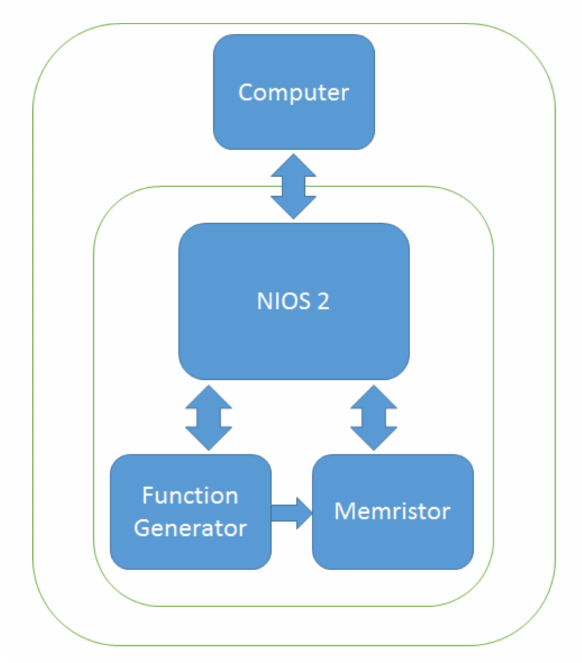
Figure 8. FPGA memristor emulator general diagram.